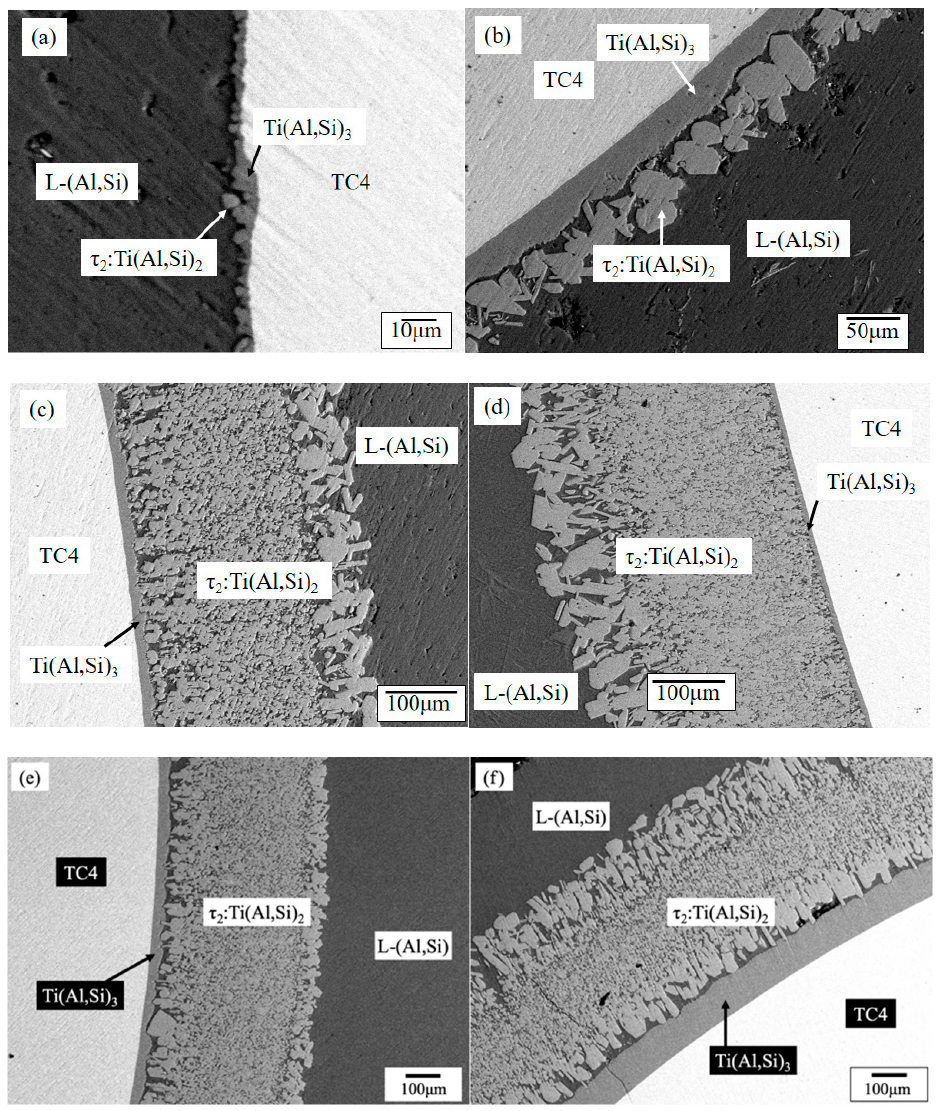
Figure 1. The microstructures of Ti-Al-Si gradient coatings on TC4 alloy at 800 °C, ( a ) 10 min, ( b ) 30 min, ( c ) 50 min, ( d ) 80 min, ( e ) 90 min, ( f ) 110 min.